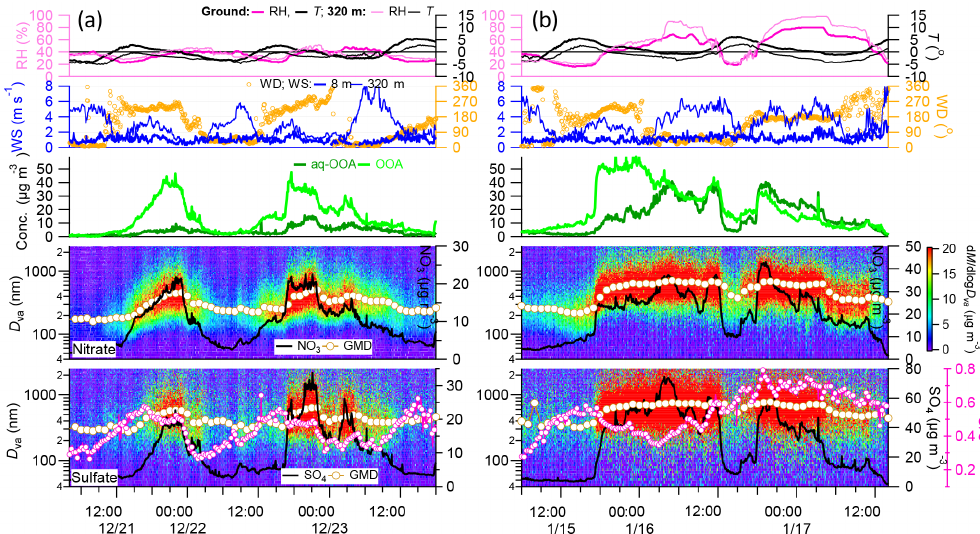
Figure 13. Evolution of meteorological parameters, SOA factors, O / C ratios and size distributions of sulfate and nitrate during two different types of episodes. The O / C ratios in the figures were calculated by excluding the contributions of COA.